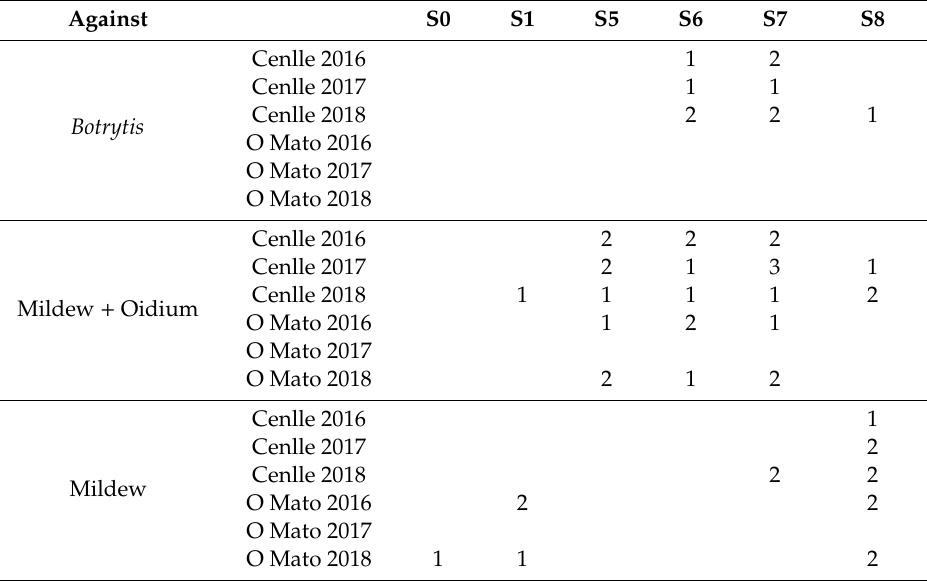
Table 2. Number of phytosanitary treatments applied in the studied plots. Against